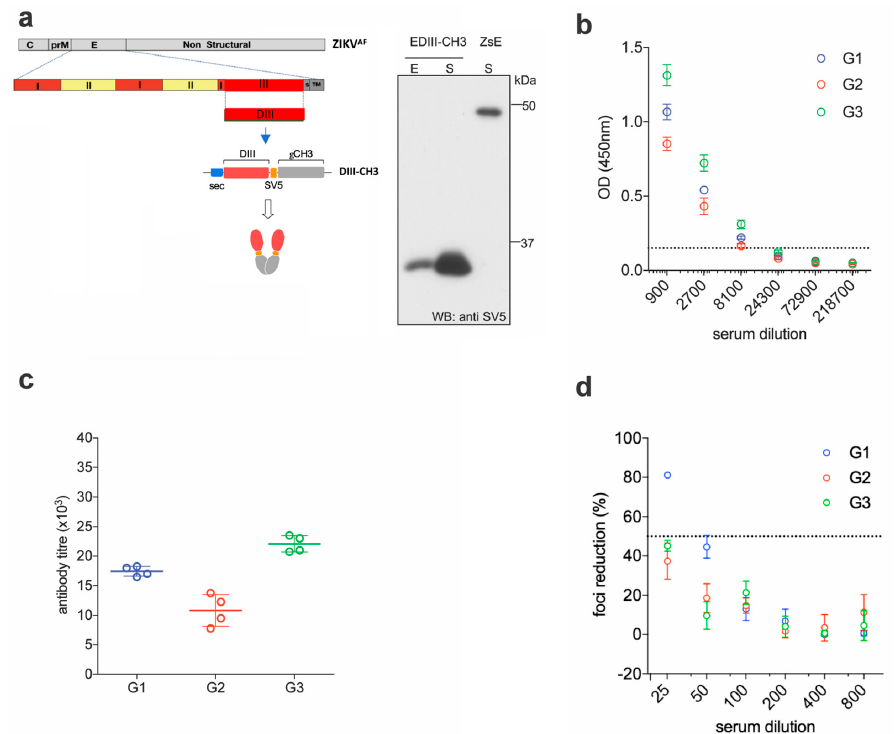
Figure 1. Functional immunogenicity of a DNA vaccine expressing ZIKV EDIII. ( a ) Schematic representation of constructs encoding ZIKV EDIII fused to the dimerizing γ CH3 domain, based on an African strain of the Zika virus (ZIKA AF ) (left) and Western blot (anti-SV5) of cellular extracts (E) and supernatants (S) from HEK293T cells transfected with the indicated constructs. Soluble ZIKV E protein from the supernatant of cells transfected with a plasmid construct expressing the SV5-tagged protein is shown for size comparison. ( b ) Pooled sera from DNA immunized mice were tested for ELISA reactivity on ZDIII-coated plates; the dashed line marks the detection limit of the assay. ( c ) Antibody titers from the curves shown in (b). ( d ) Foci reduction neutralization test (FRNT) of ZIKV on Vero cells with pooled sera from mice immunized with